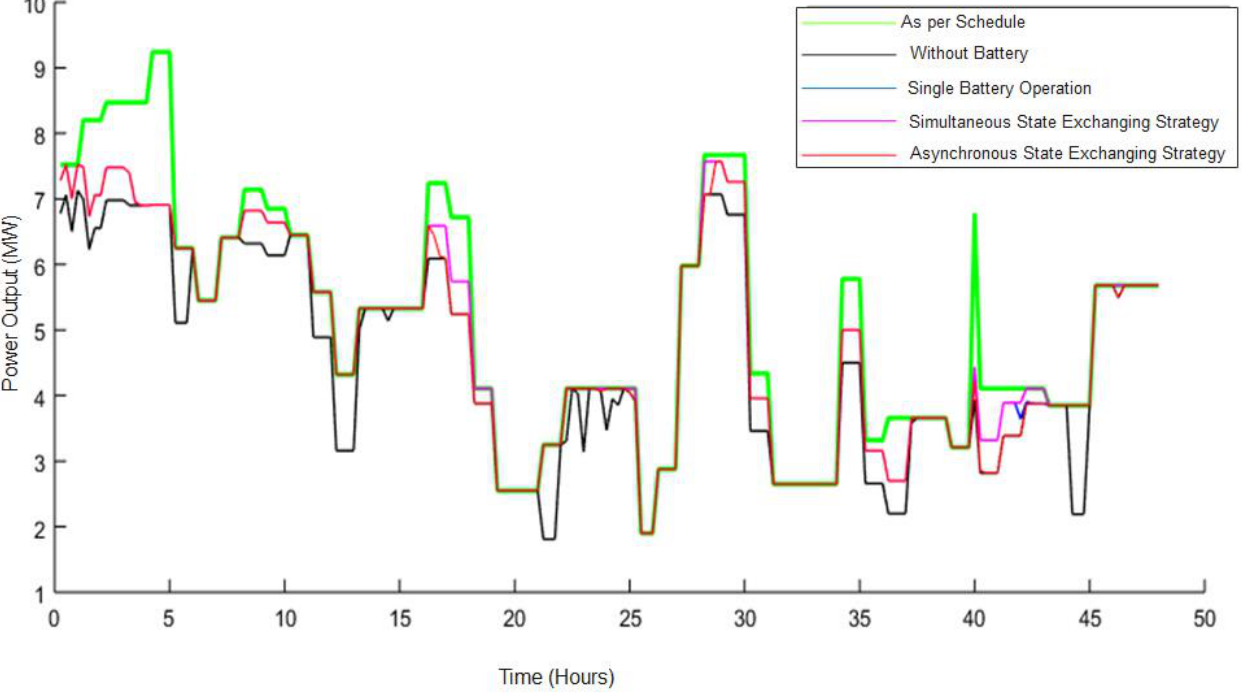
Figure 11. Power curve of output of BESS-integrated wind farm when 2 MW of battery. Table 6. Performance indices of BESS-integrated wind farm with 2 MW battery.